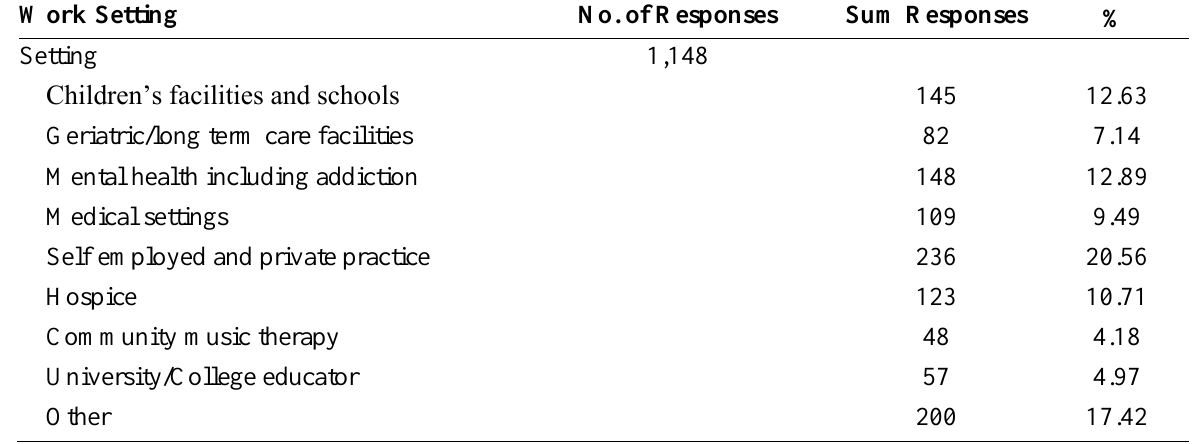
Work Settings of Survey Respondents Work